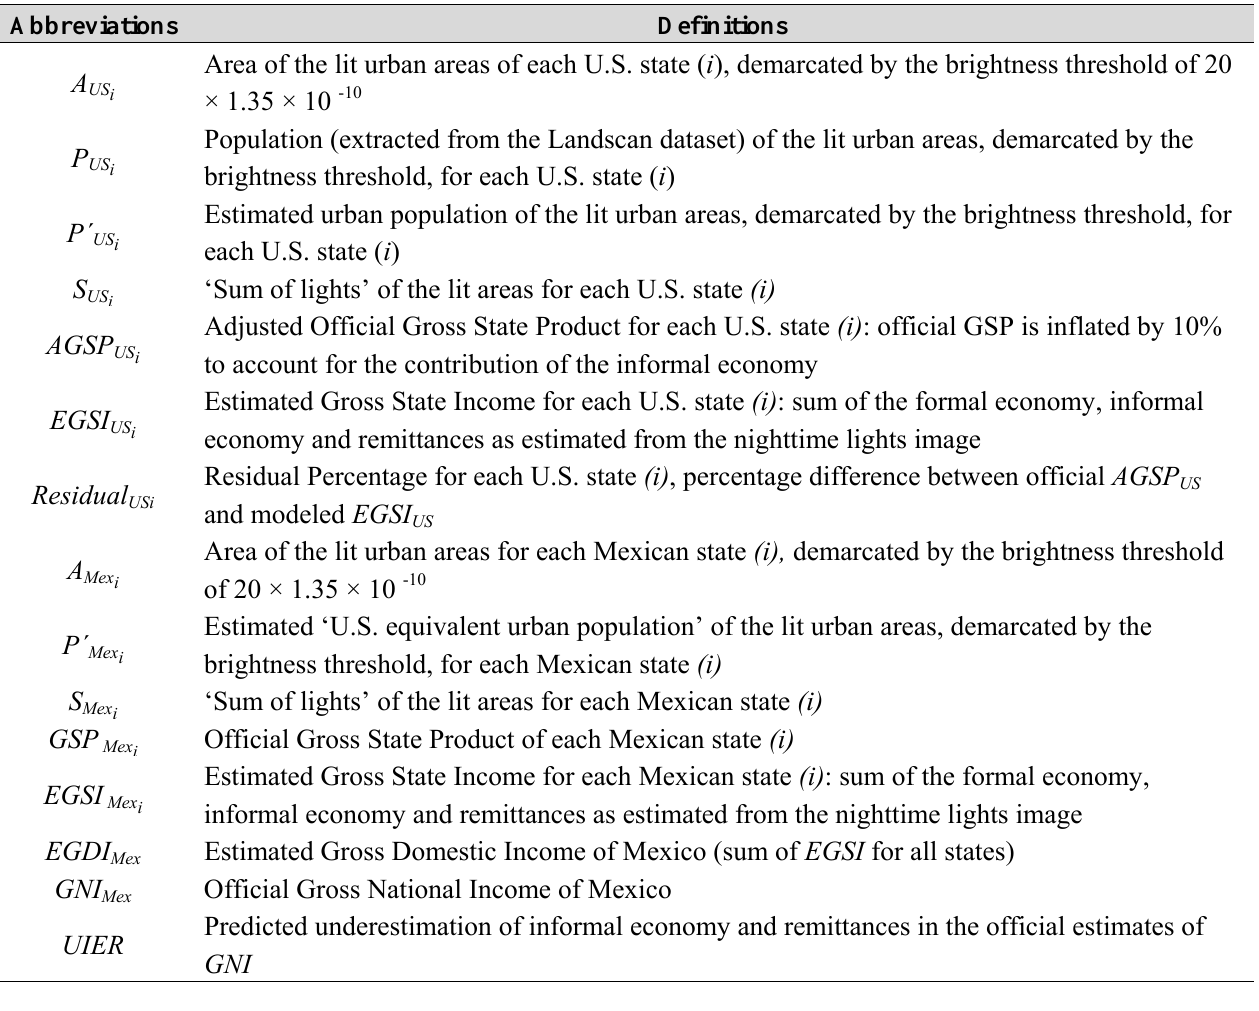
Table 4. Abbreviations and definitions of the different economic variables used in the